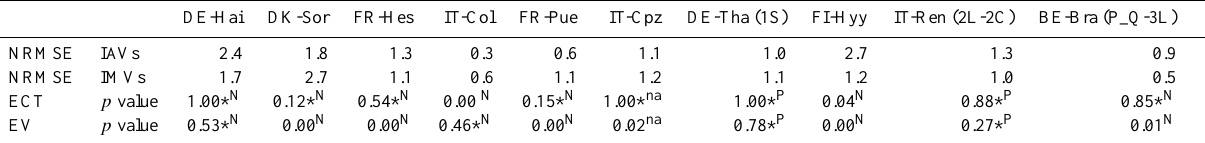
Table 2. IMV and IAV NRMSE for the analysed sites. Each specific IMV distribution was tested for normality goodness of fit (N = normal distribution, P = non-normal distribution). A test for equivalence of central tendency was performed between IMV MD and IMV EC values. (na) refers to the case of sites with inconsistent distributions (one normally, one not normally distributed). The (*) marks refer to the acceptance of the null hypothesis that the two distributions are equivalent for the specific statistic ( α = 0.05). ECT stands for “Equivalence for Central Tendency”; EV for “Equivalence for Variance”.